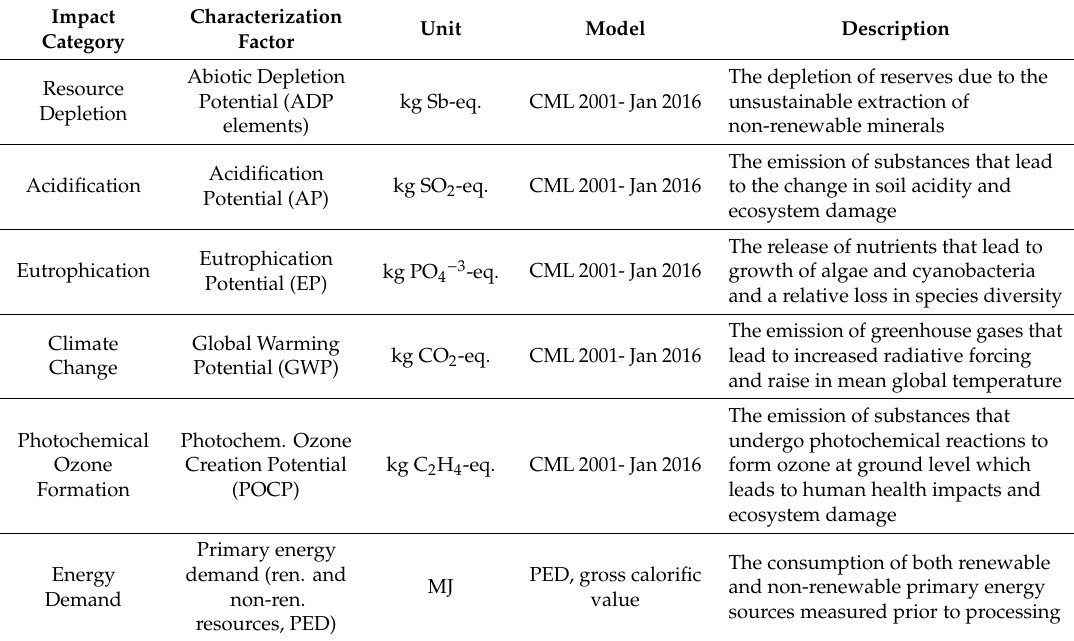
Table 4. Description of impact categories